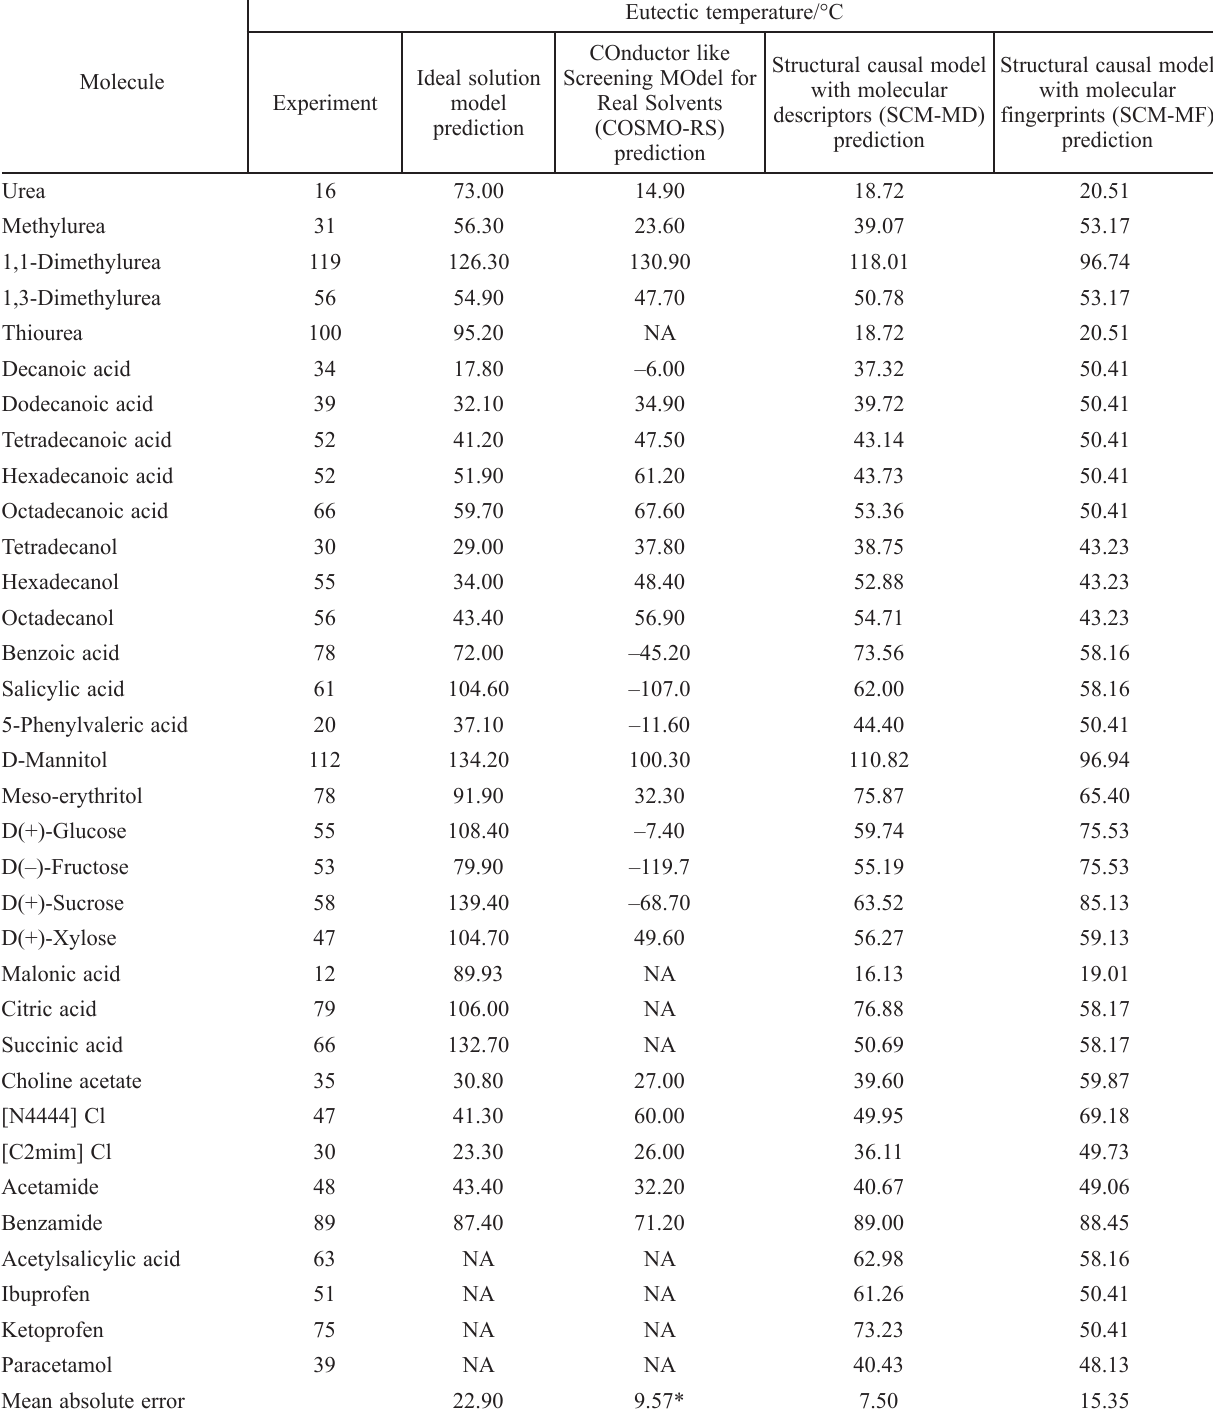
Table 1 – Molecule dataset used for model training and the predicted eutectic temperatures Molecule